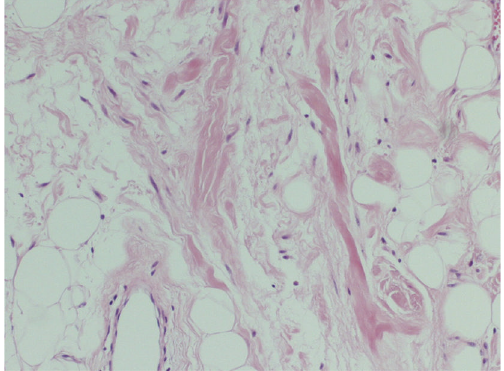
Figure 6: High-power showing spindle cells arranged in parallel fascicles within collagenous stroma (H&E x100).